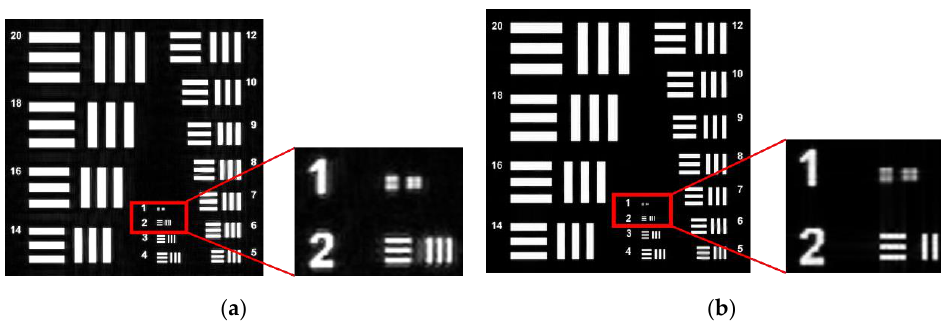
Figure 12. Partial enlargement of Figure 11: ( a ) Partially magnify the results of AMPR recovery; ( b ) Partially magnify the results of Algorithm 1 recovery. When we use the camera sub-sampling